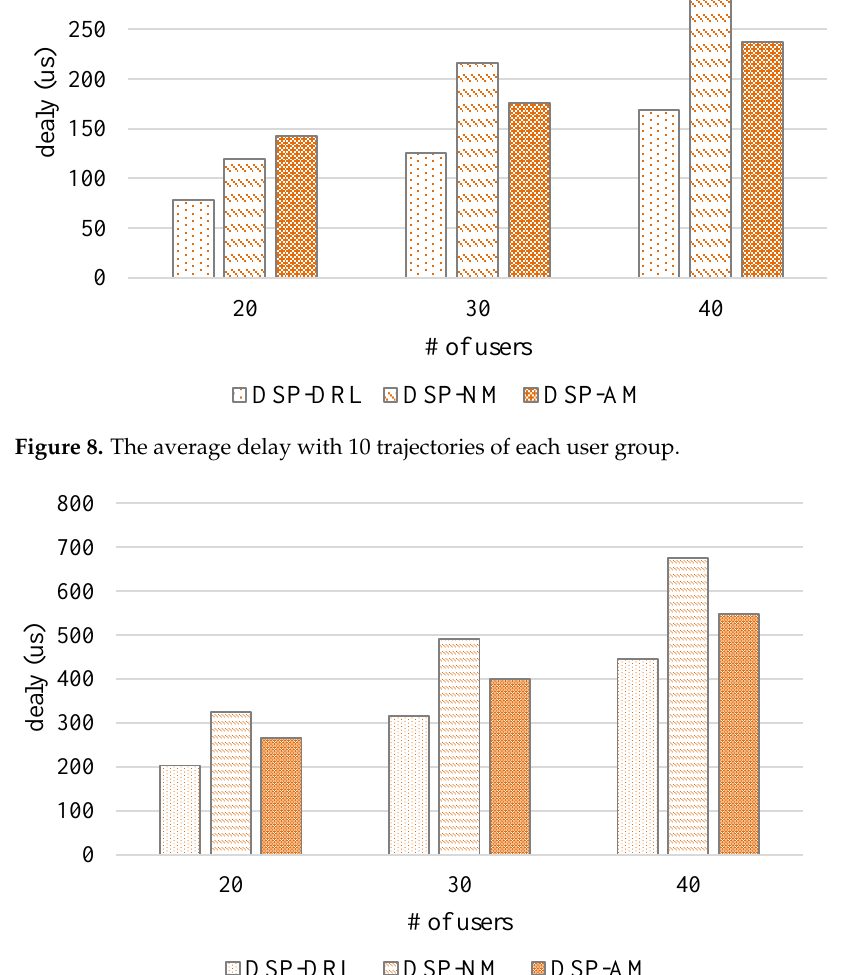
Figure 9. The average delay with 20 trajectories of each user